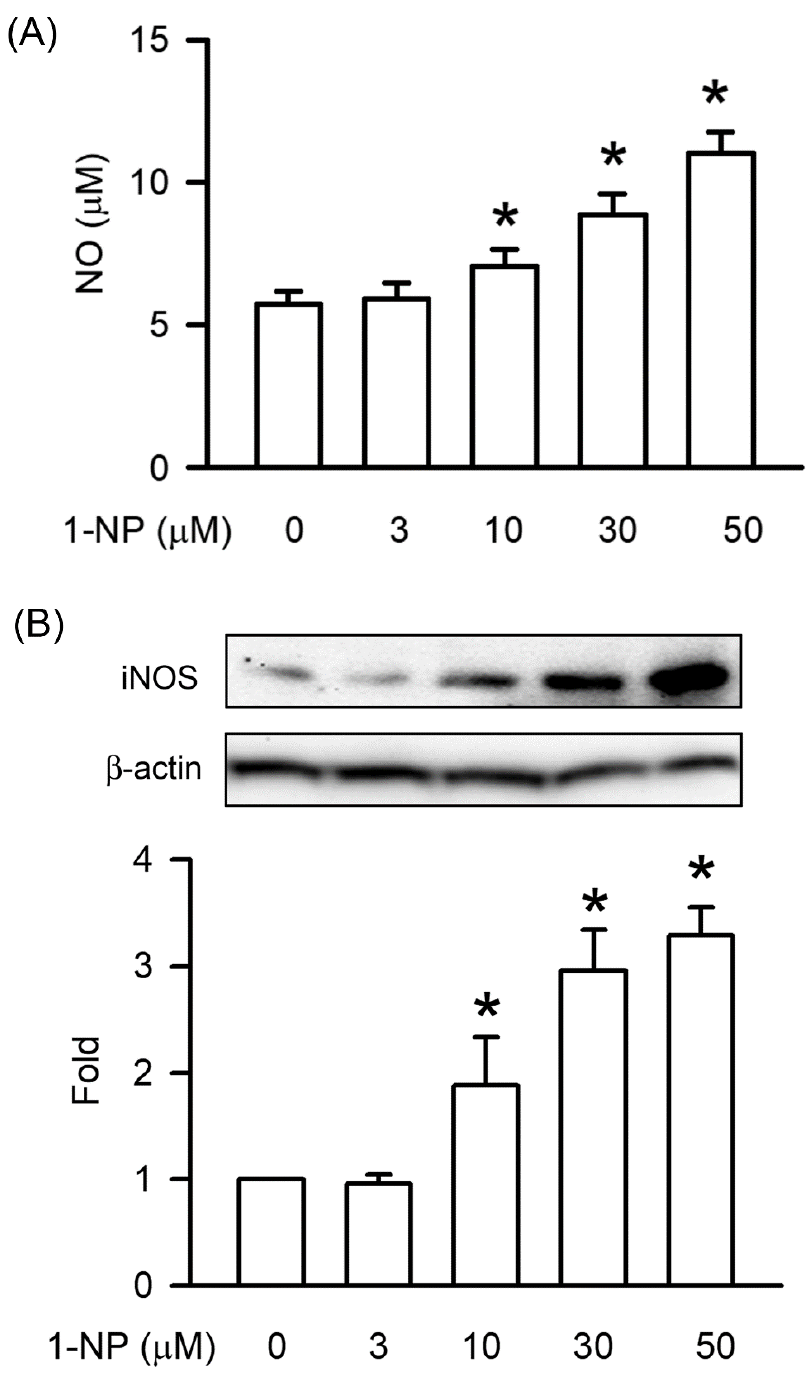
Figure 2. NO generation and iNOS expression were induced by 1-NP in RAW264.7 macrophages. The level of NO generation ( A ) and iNOS expression ( B ) was measured by a Griess reaction assay and Western blotting assay, respectively. Results are expressed as means ± SD ( n = 3). * p < 0.05 is considered significant, compared with the control group, which indicated treatment with 1-NP at 0 μ M.